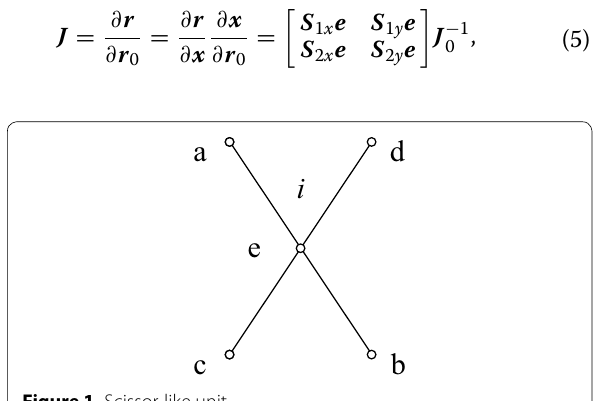
Figure 1 Scissor-like